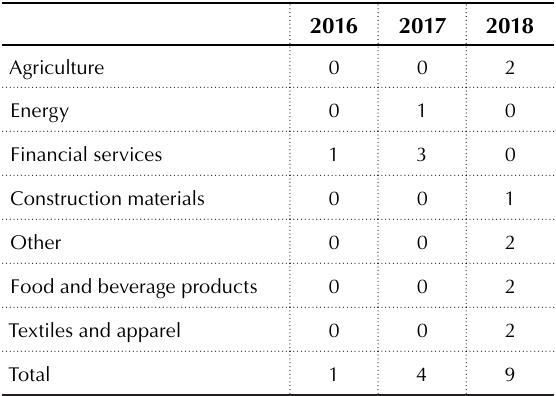
Table 2. SR in Ghana for the period of 2008–2018 by the companies’ sector